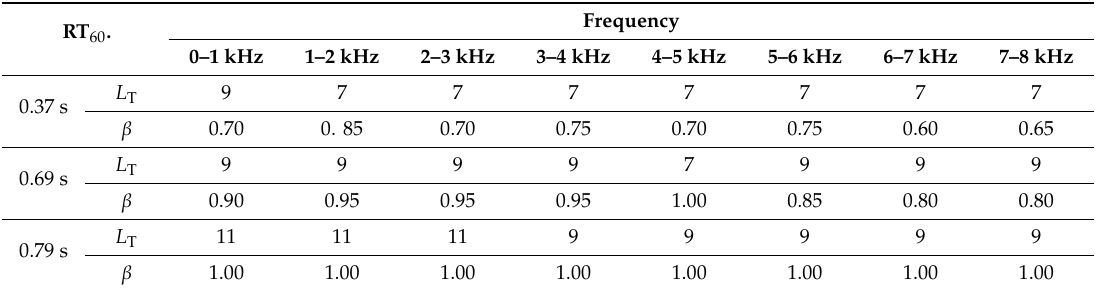
Table 2. Optimal L T and β according to the frequency intervals and reverberation environment using a 25-ms Hamming window, 10-ms hop length, and 512-point FFT.